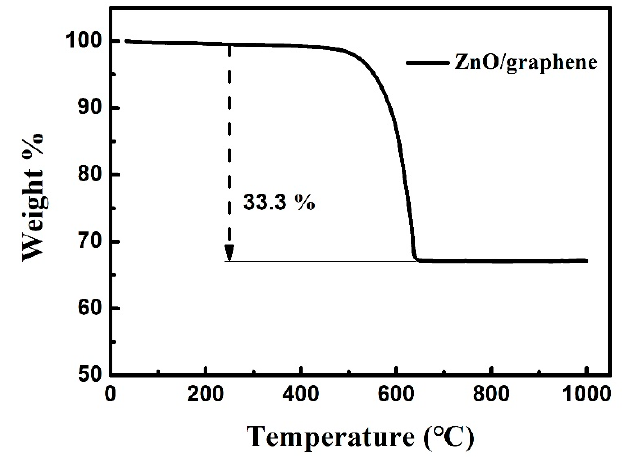
Figure 6. Thermogravimetric analysis (TGA) analysis of the ZnO/graphene composite.